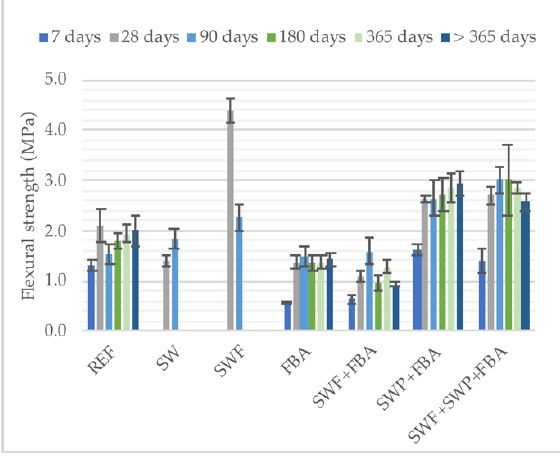
Figure 3. Flexural strength test results.